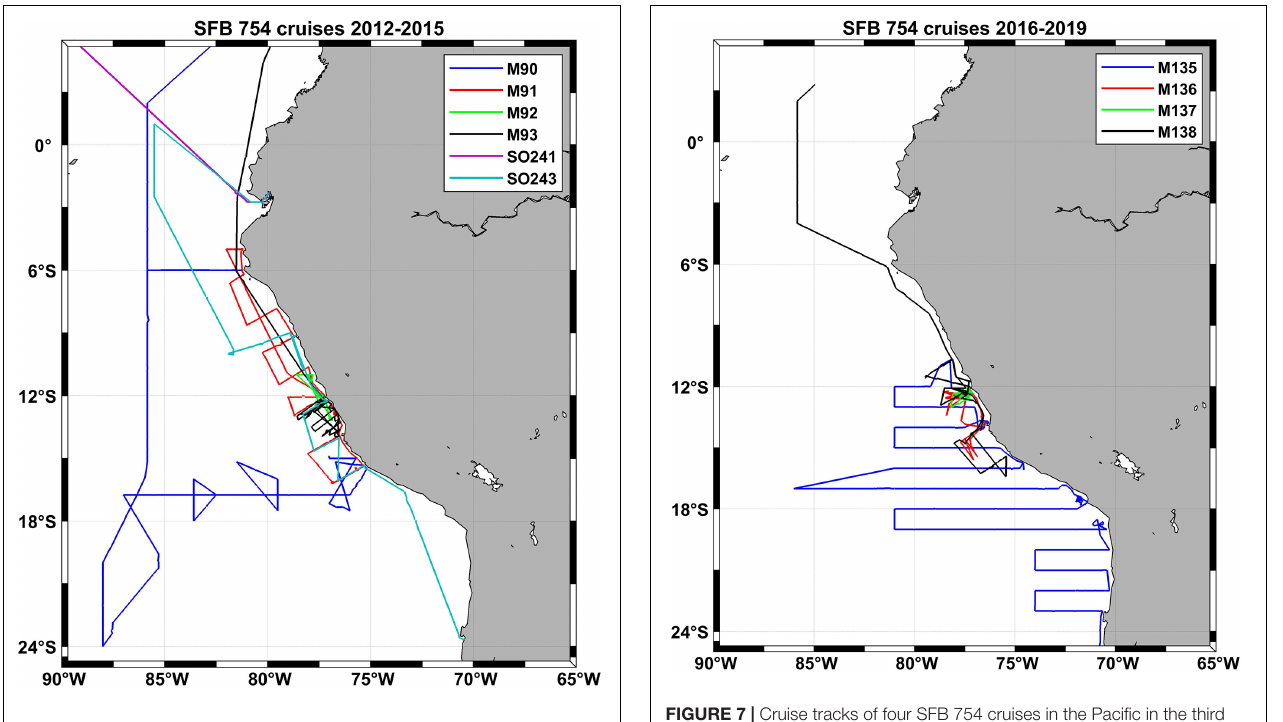
(2018) with calibration of all elements via standard